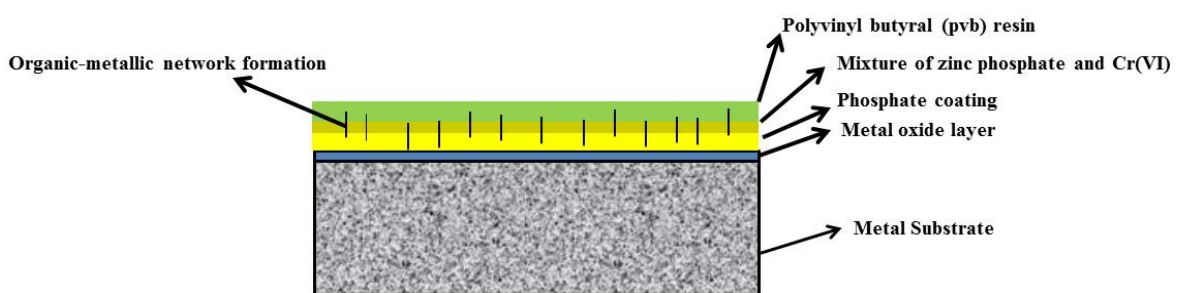
Figure 1. Schematic diagram of multi-layer Cr(VI)-based Army wash primer (DOD-P-15328D) coating on metal